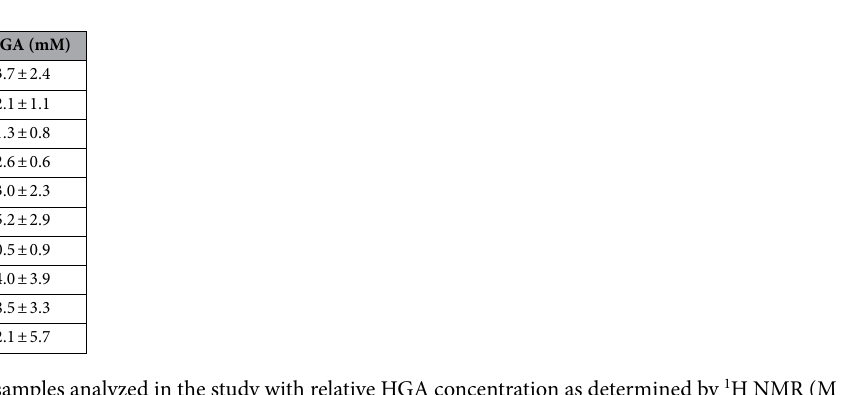
Table 1. Urine samples analyzed in the study with relative HGA concentration as determined by 1 H NMR (M = male, F =